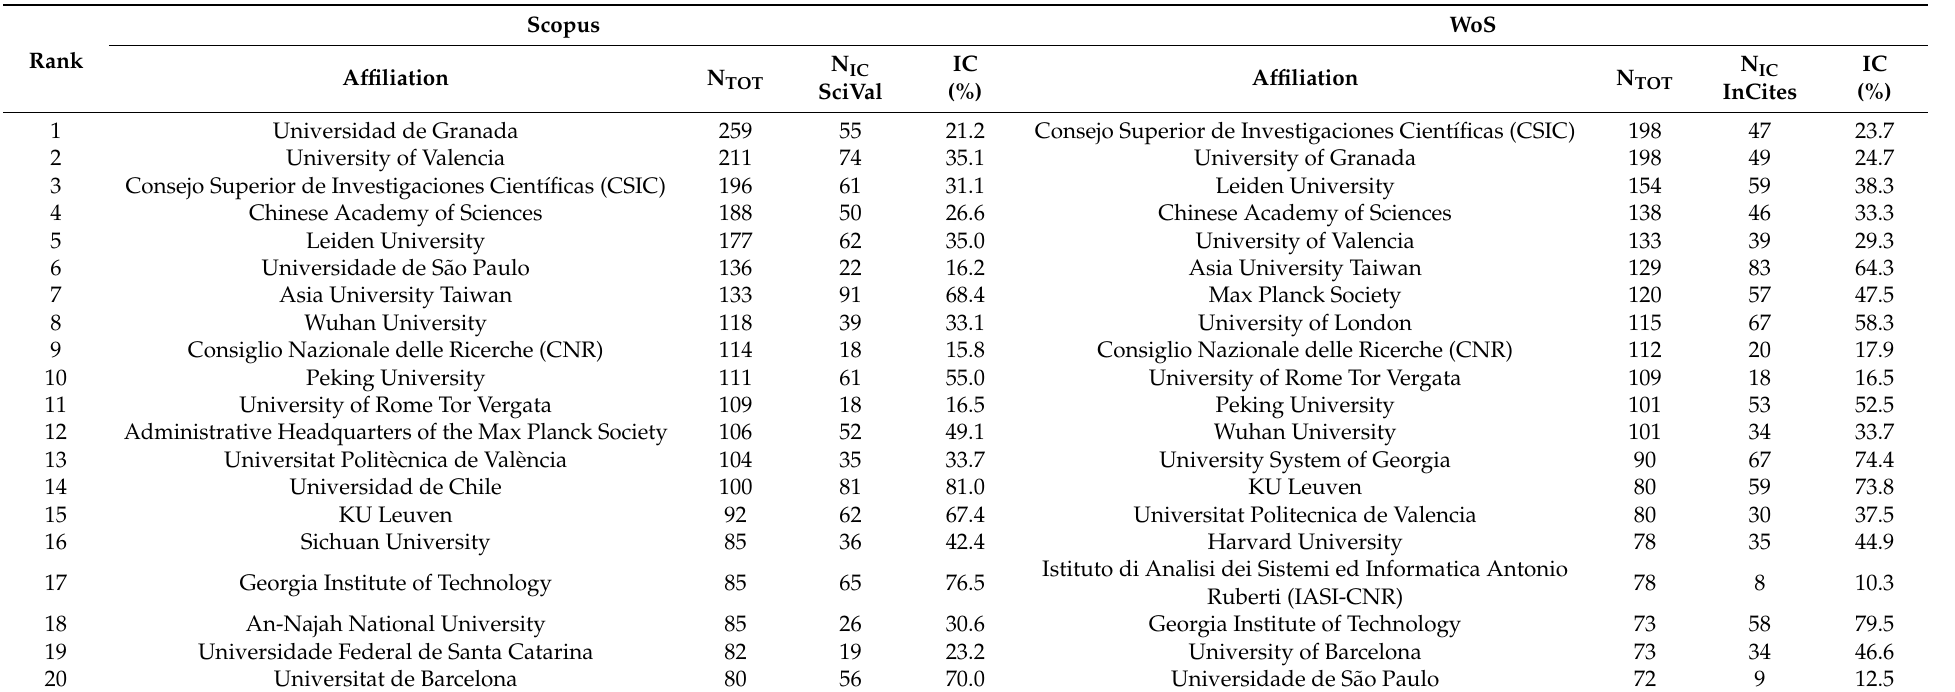
Table 1. Main affiliations according to Scopus and